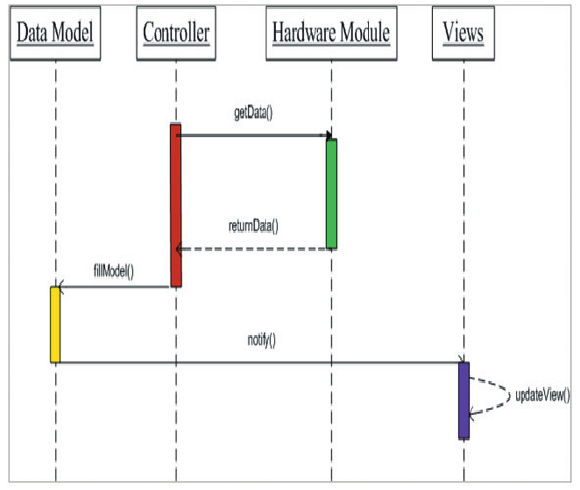
Fig.3: Model, Views and Controller interactions